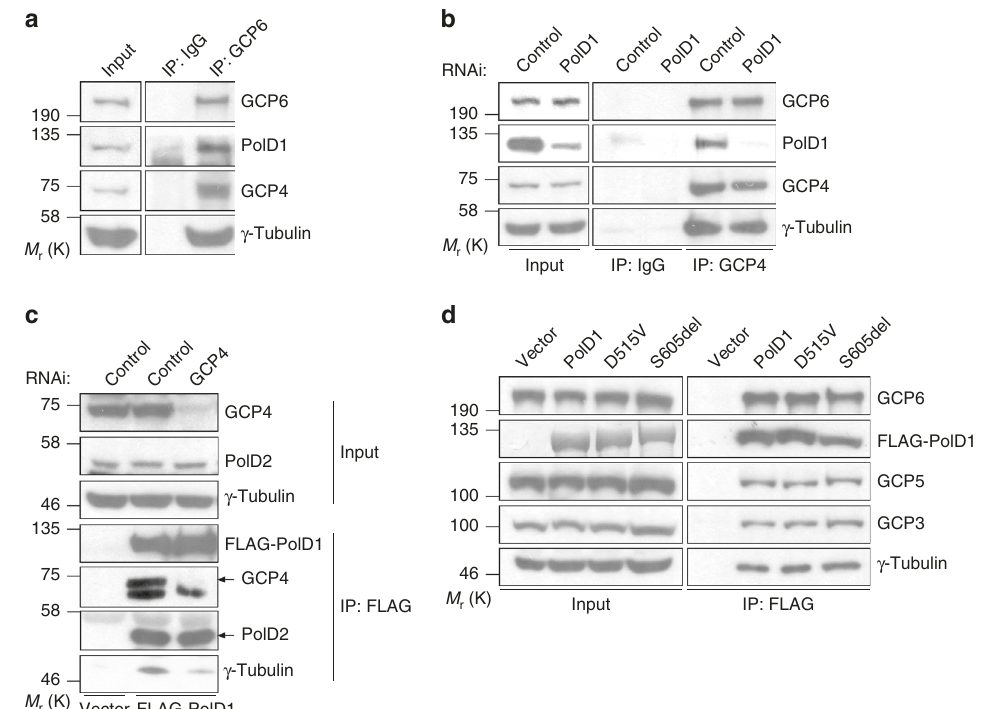
Fig. 1 PolD1 associates with γ TuRCs. a Anti-GCP6 immunoprecipitation was performed using HEK293T cell extracts; normal rabbit IgG was used in the control immunoprecipitation. The immunoprecipitates were immunoblotted with the indicated antibodies. b HEK293T cells were transfected with control or pold1 -targeting siRNAs, and then immunoprecipitation was performed using normal rabbit IgG or anti-GCP4 antibody. c FLAG-PolD1 was expressed in cells that were transfected with a GCP4-speci fi c siRNA (or a control siRNA), and then anti-FLAG immunoprecipitation was performed. The immunoprecipitates and the lysate inputs were immunoblotted with the indicated antibodies. FLAG-PolD1 was detected through anti-FLAG immunoblotting. d Extracts of HEK293T cells ectopically expressing PolD1 or its mutants (D515V and S605del) were used for anti-FLAG